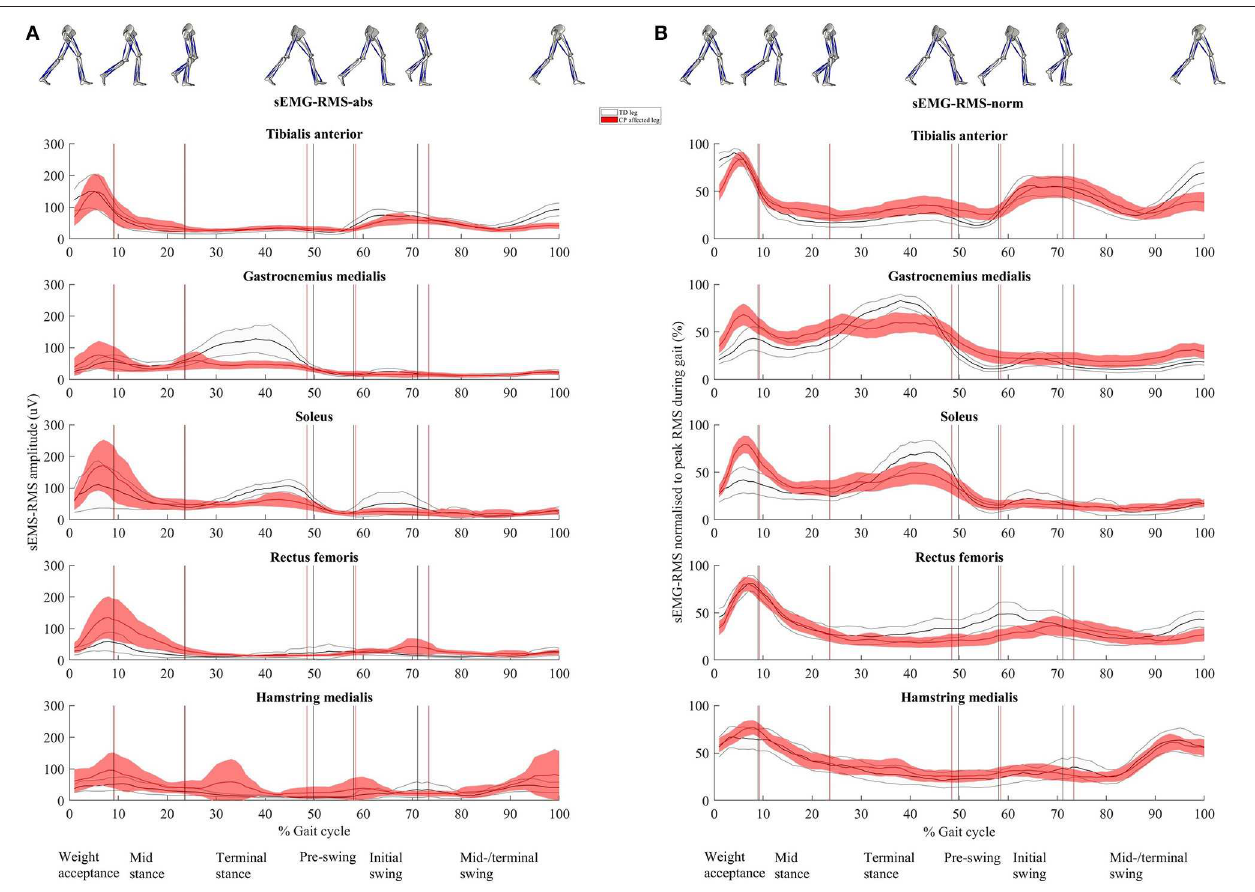
FIGURE 3 | (A) Root mean square (RMS) surface electromyographic (sEMG) amplitude ( µ V, sEMG-RMS-abs) and (B) RMS of sEMG normalized to peak RMS obtained during the gait cycle (%, sEMG-RMS-norm) for the five muscles. Time normalized to 0 to 100% of the gait cycle. Presented as mean (solid line) with 95% confidence interval (shaded area). The vertical lines represent the mean timing of the different events dividing the gait cycle into the six gait phases (named in the bottom line). Gray color is used for the healthy legs of typically developing children and red for the affected legs of children with CP. Illustrations of the right leg’s events, separating the different phases, are seen at the top.